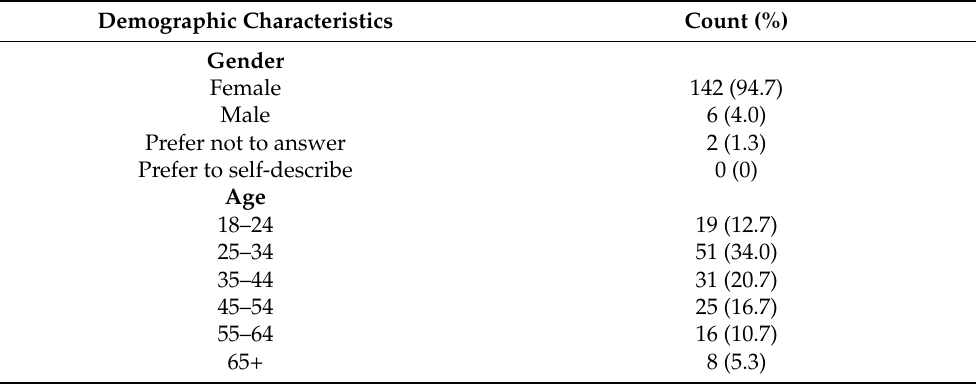
Table 1. Demographic characteristics of